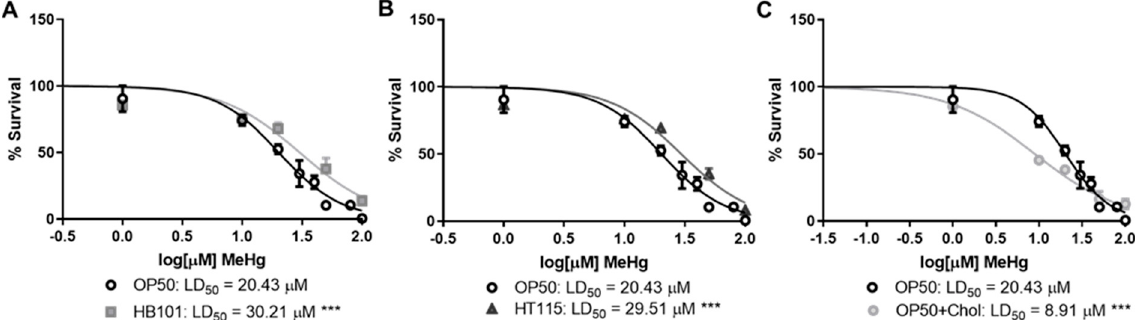
Figure 1. Diet affects MeHg toxicity. N2 worms were treated with increasing concentrations of MeHg for 30 min and then transferred to NGM plates seeded with either OP50 or ( A ) HB101, ( B ) HT115, or ( C ) OP50 supplemented with cholesterol. Dose–response survival curves were generated and LD 50 values were calculated from five independent experiments. *** p < 0.001 as compared with N2 MeHg-treated worms fed OP50.